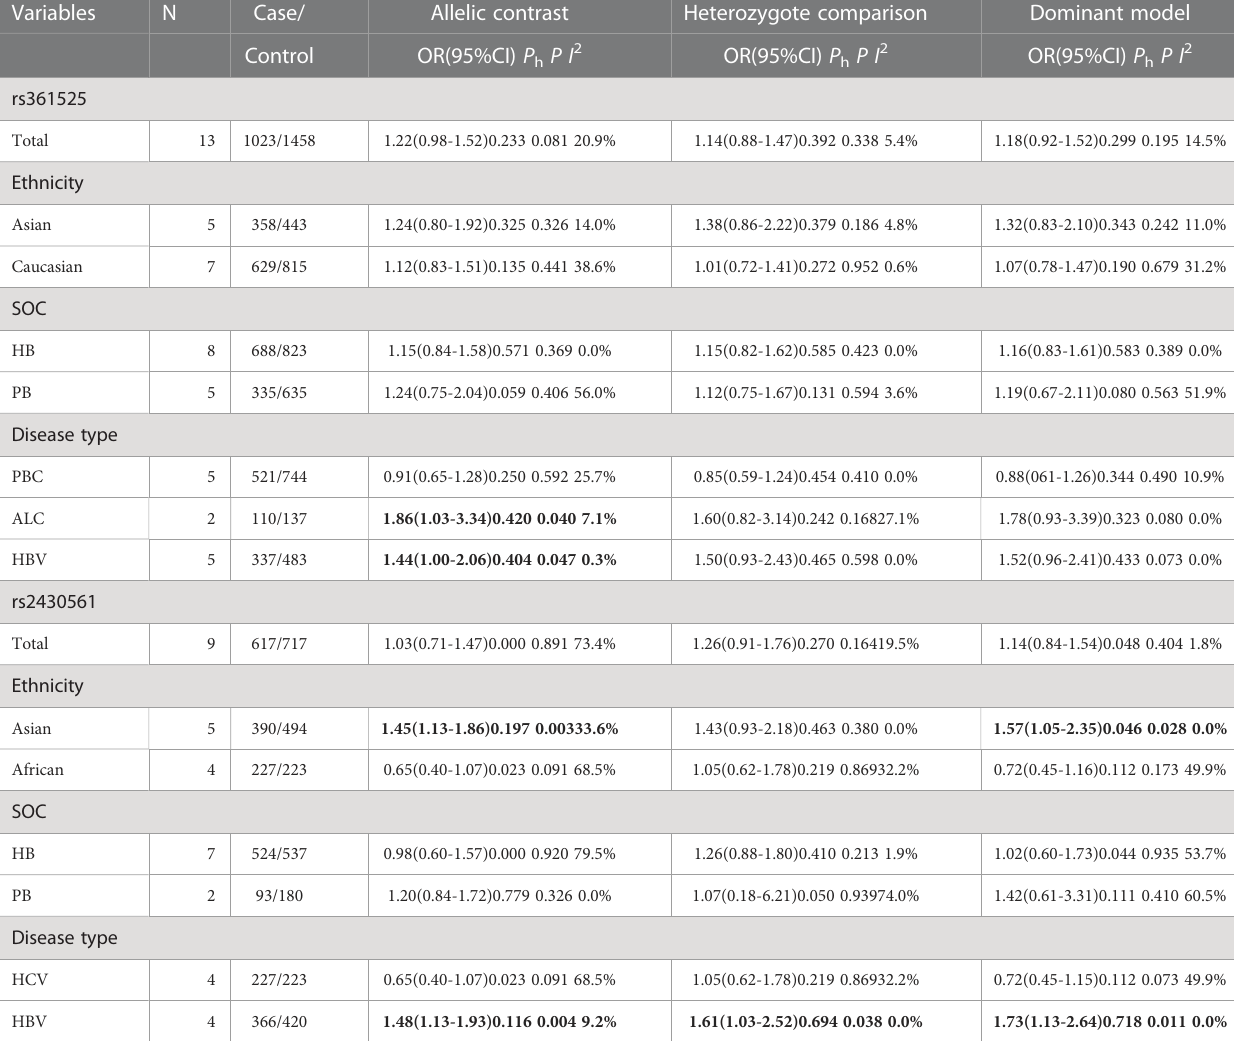
TABLE 2 Strati fi ed analyses of TNF- a and IFN- g genes ’ common polymorphisms on cirrhosis of liver risk.